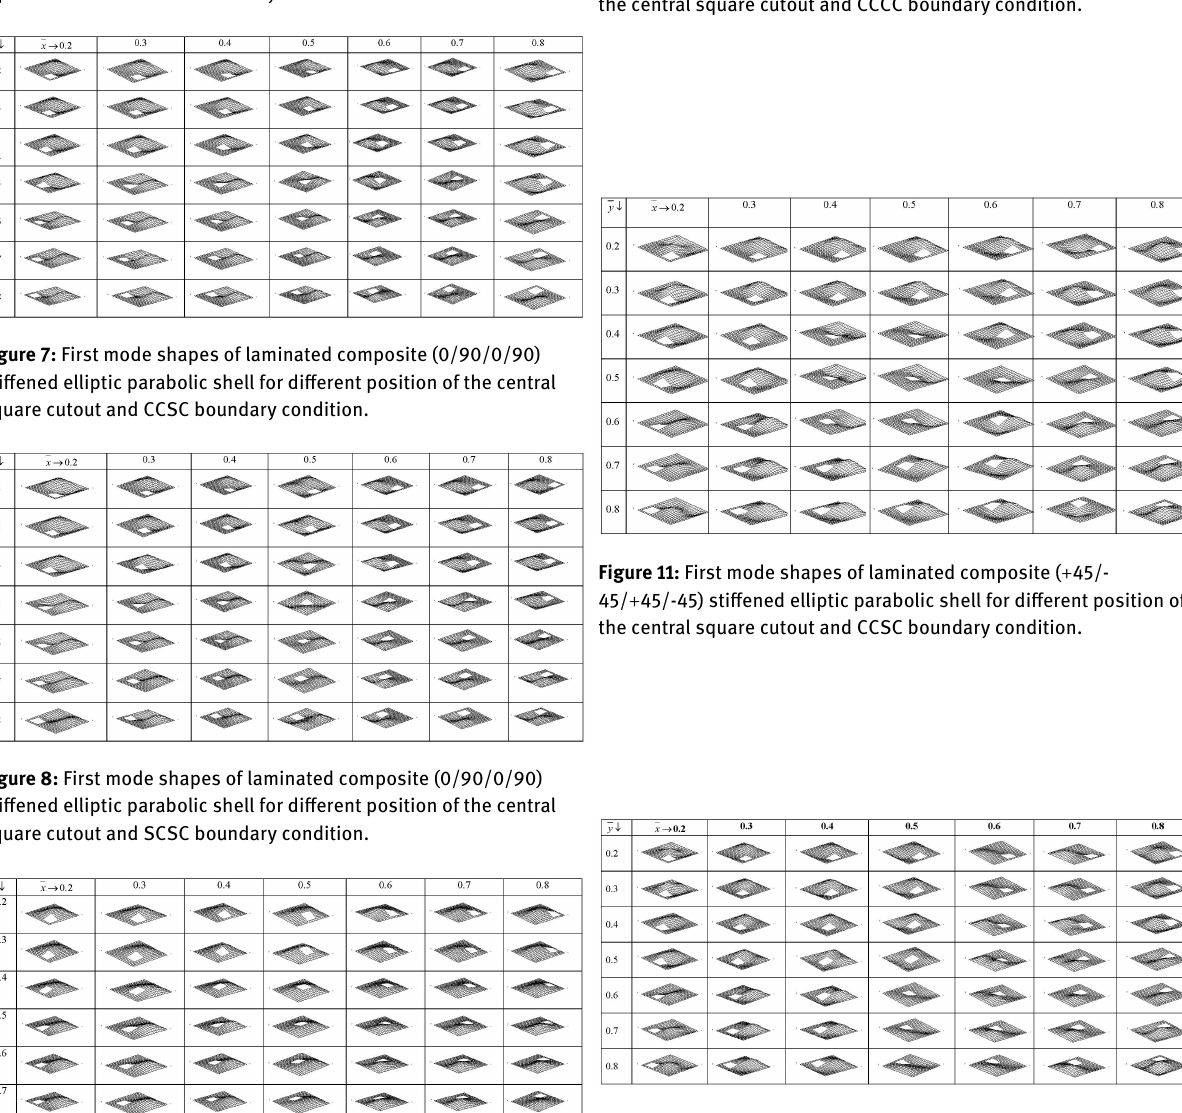
Figure 12: First mode shapes of laminated composite ( + 45/- 45/ + 45/-45) stiffened elliptic parabolic shell for different position of the central square cutout and SCSC boundary